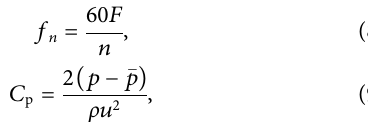
Frontiers in Energy Research |